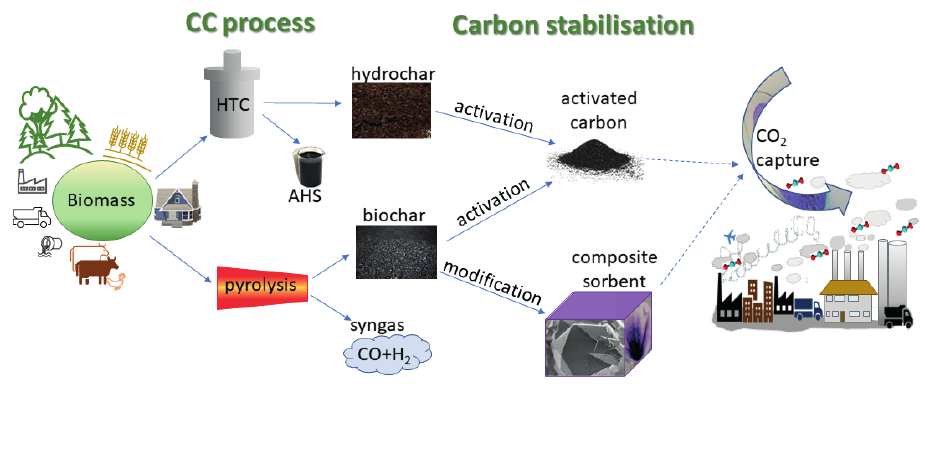
Fig. 1. Concept of carbon capture process and carbon stabilisation using thermochemical processing of biomass